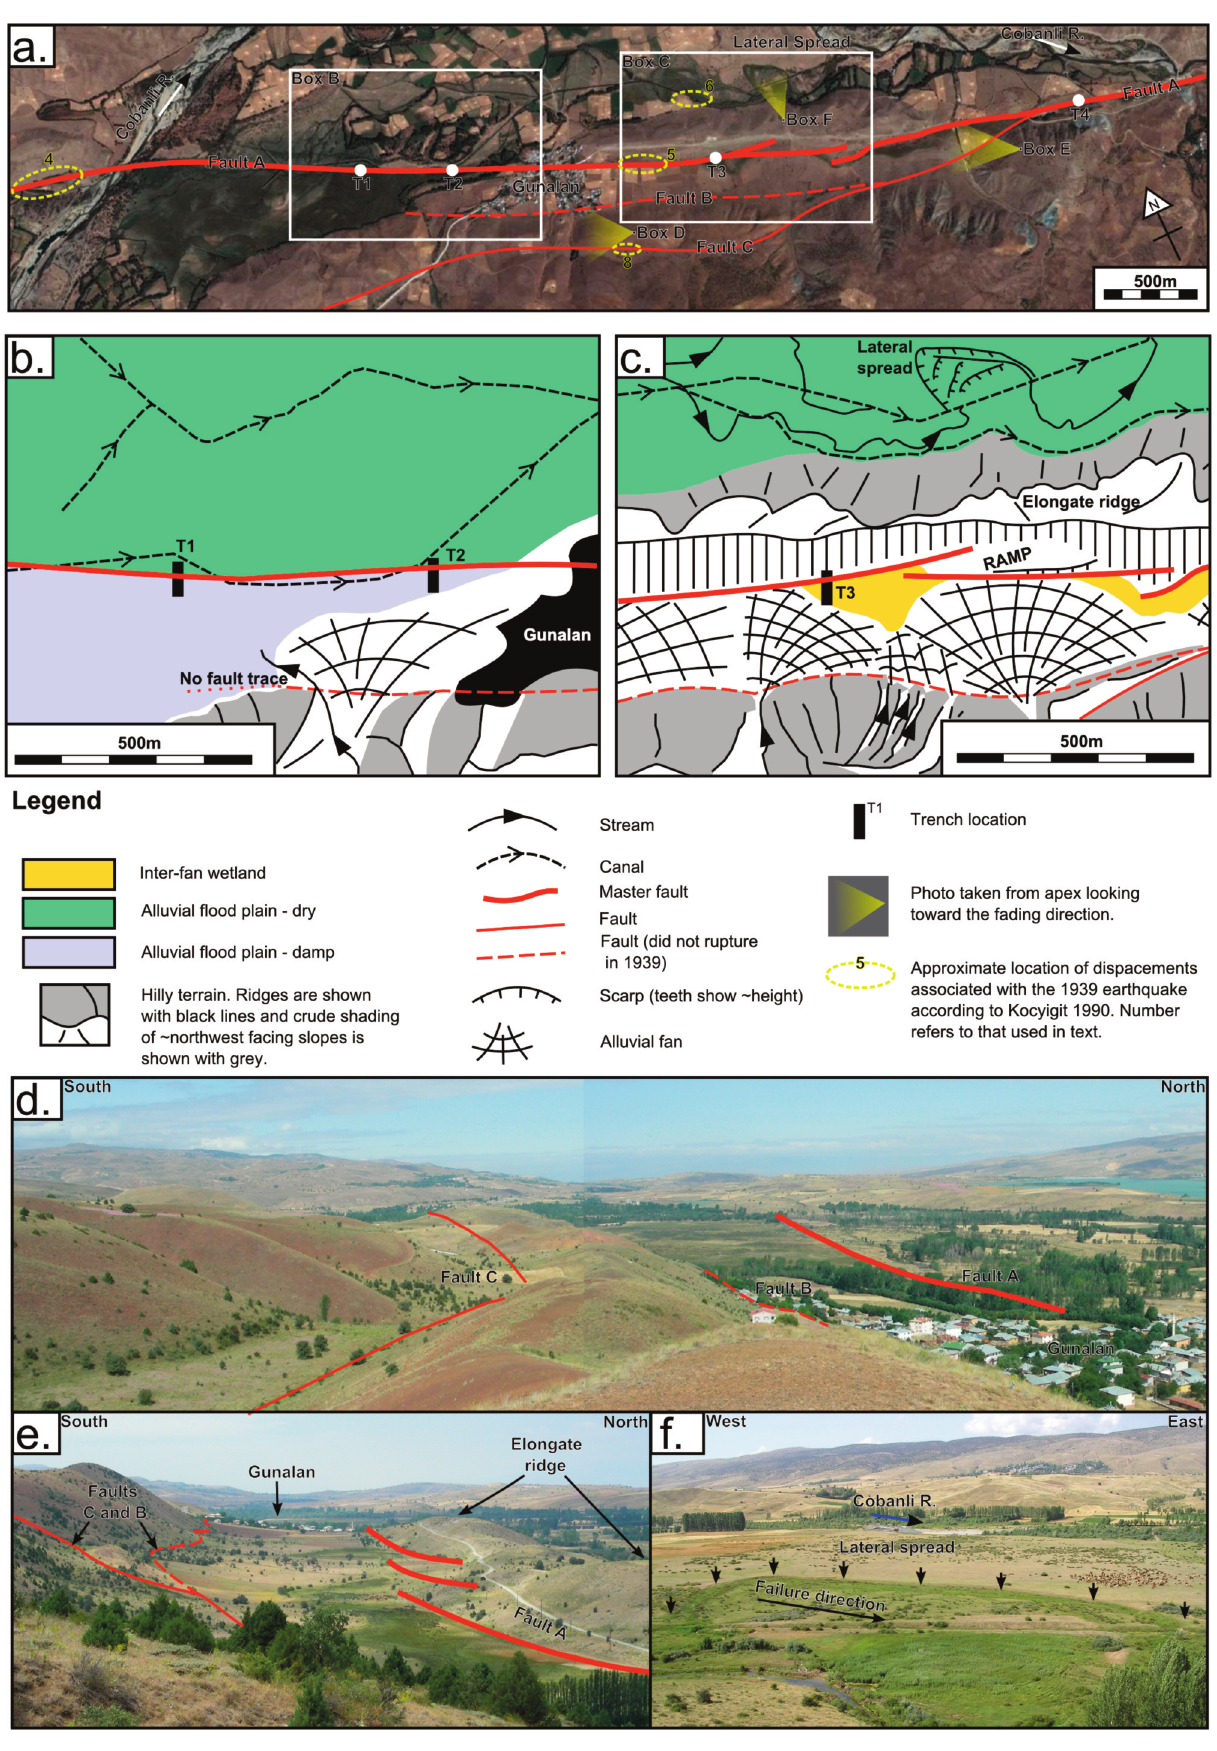
Figure 2. (a) Fault map of the study area over a satellite image with key features highlighted. (b, c) Geomorphic maps of areas near paleoseismic trenches. (d) Photograph showing Faults C and A. (e) Photograph showing Faults A and B, and the depression in between. (f) Photograph showing the lateral spread the structure that is depicted in box c. The locations and orientations of the photographs in Figure 2 d-f are shown in Figure